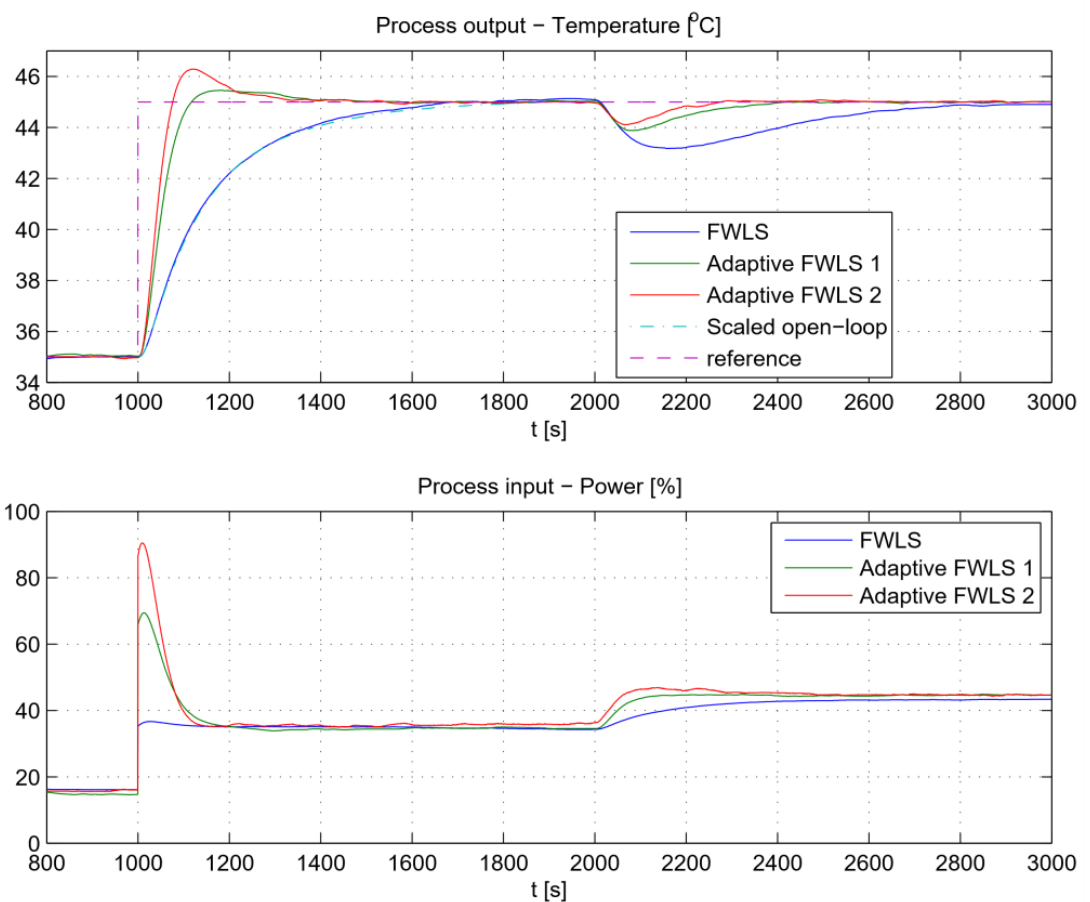
The closed-loop responses for all three cases, to the reference change from 35 ◦ C to 45 ◦ C at t = 1000 s and to the − 10% process input disturbance at t = 2000 s, are shown in Figure 25. The sampling time was T S = 0.5 s. It can be seen that the closed-loop response of the original FWLS method (blue solid line) is virtually identical to the amplitude-scaled process open-loop response (cyan dash-dotted line). The adaptive algorithms provide significantly faster responses. The adaptive FWLS 1 response is slower than the adaptive FWLS 2 response. On the other hand, the adaptive FWLS 1 method exhibits a smaller overshoot (less than 5%) for a reference change, all according to the selected maximum overshoot. The adaptive FWLS 2 method has the best disturbance-rejection performance.